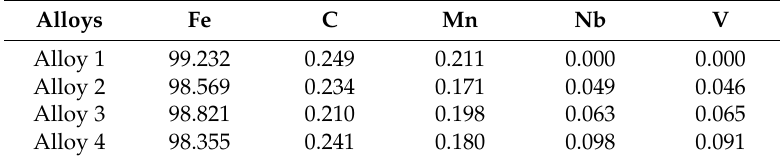
Table 2. Chemical composition of Alloys 1–3 and Alloy 4 obtained by the OES method.